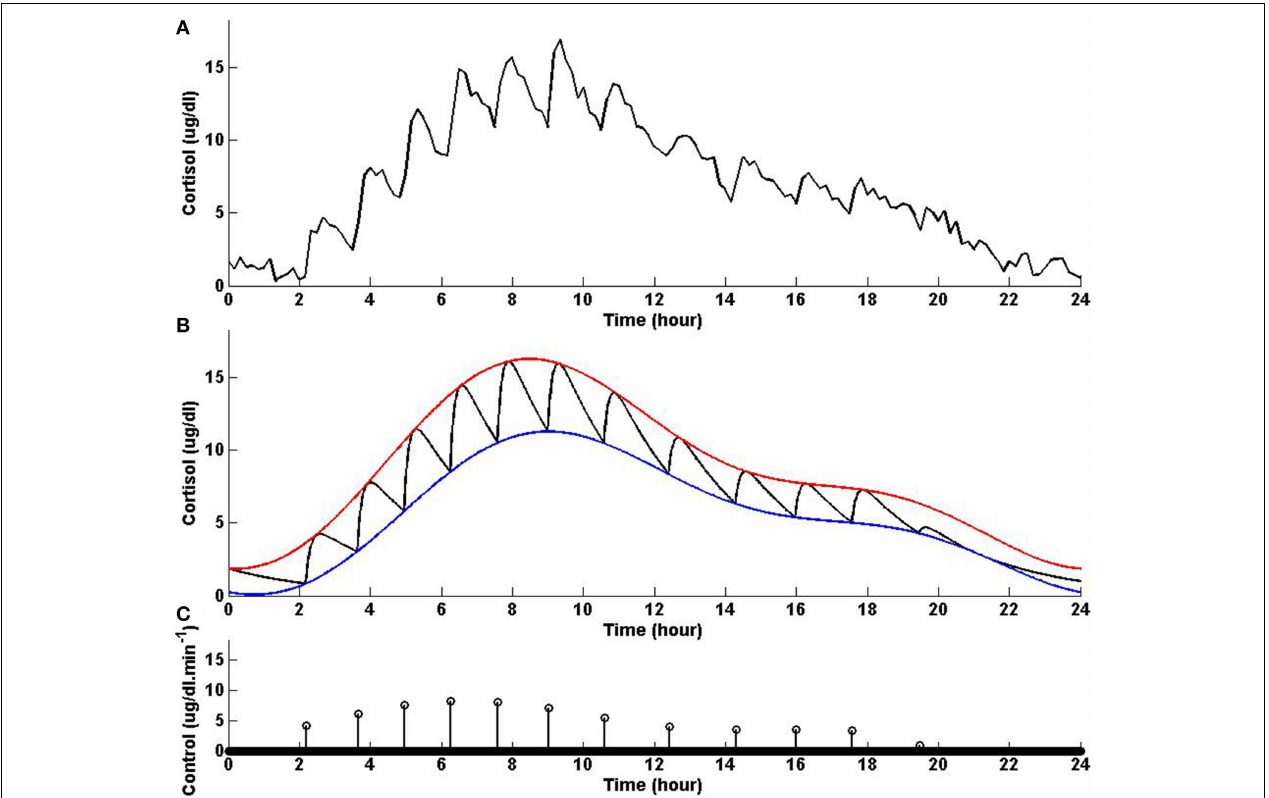
displays the obtained control. The optimization problem obtained 12 impulses over 24 h as the control (the timing of the control was discretized into 1440 points; the obtained control takes 12 non-zero values, i.e., impulses, while it is zero everywhere else). The optimization problem was solved using the parameters given in Example 4 in Table 1 and the upper and lower bounds provided in Tables 2 , 3 ,